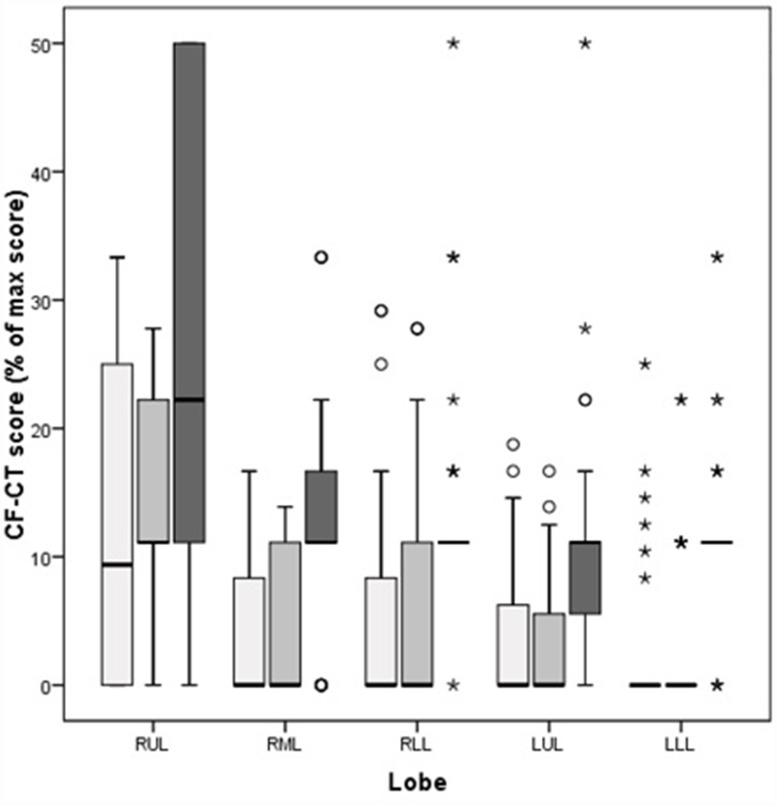
Comparison of CF-CT subscores per lobe.Comparison of CF-CT subscores per lobe, presented as % of max CF-CT score. Data are presented as median (range), unless otherwise indicated. White bars represent bronchiectasis score, light grey bars represent airway wall thickening score and dark grey bars represent air trapping score. RUL = right upper lobe (n = 22), RML = right middle lobe (n = 22), RLL = right lower lobe (n = 40), LUL = left upper lobe (n = 39), LLL = left lower lobe (n = 39).